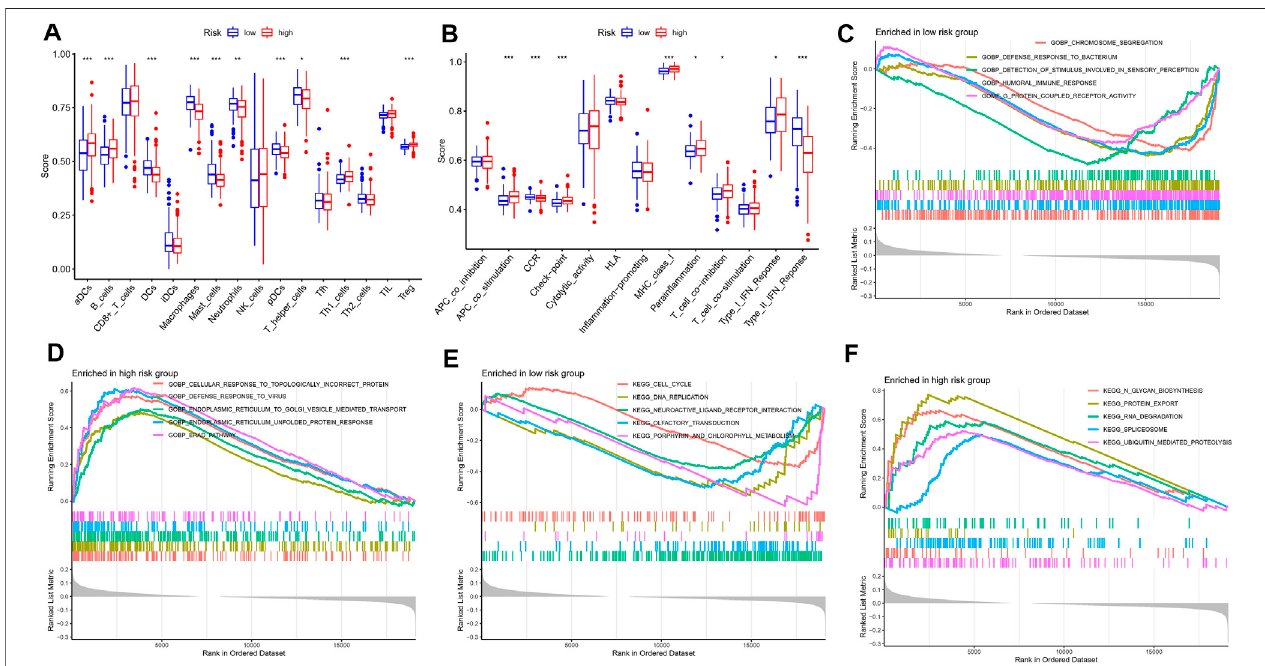
FIGURE 7 | Immune in fi ltration analysis and GSEA. (A) A box plot showed difference of 21 immune cells in different risk subgroups. (B) A box plot showed difference of eight immune related pathways in different risk subgroups. (C,D) GSEA analysis in the high-risk group. (E,F) GSEA analysis in the low-risk group.